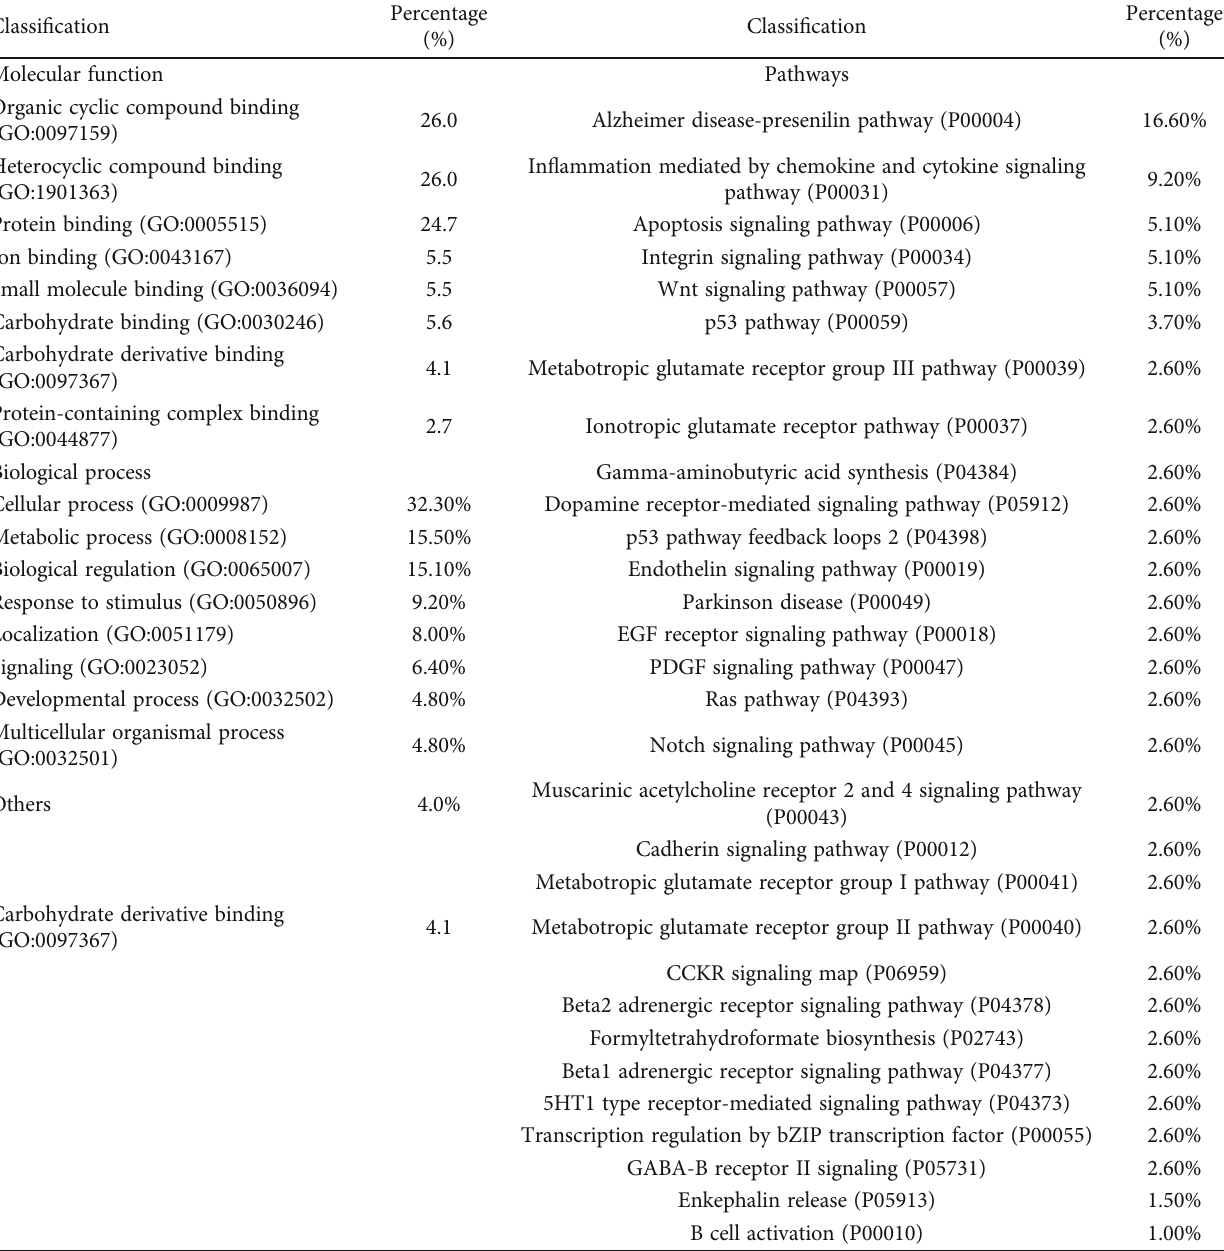
Table 6: Unique glycoproteins in the AD group classi fi ed by the molecular function, biological process, and